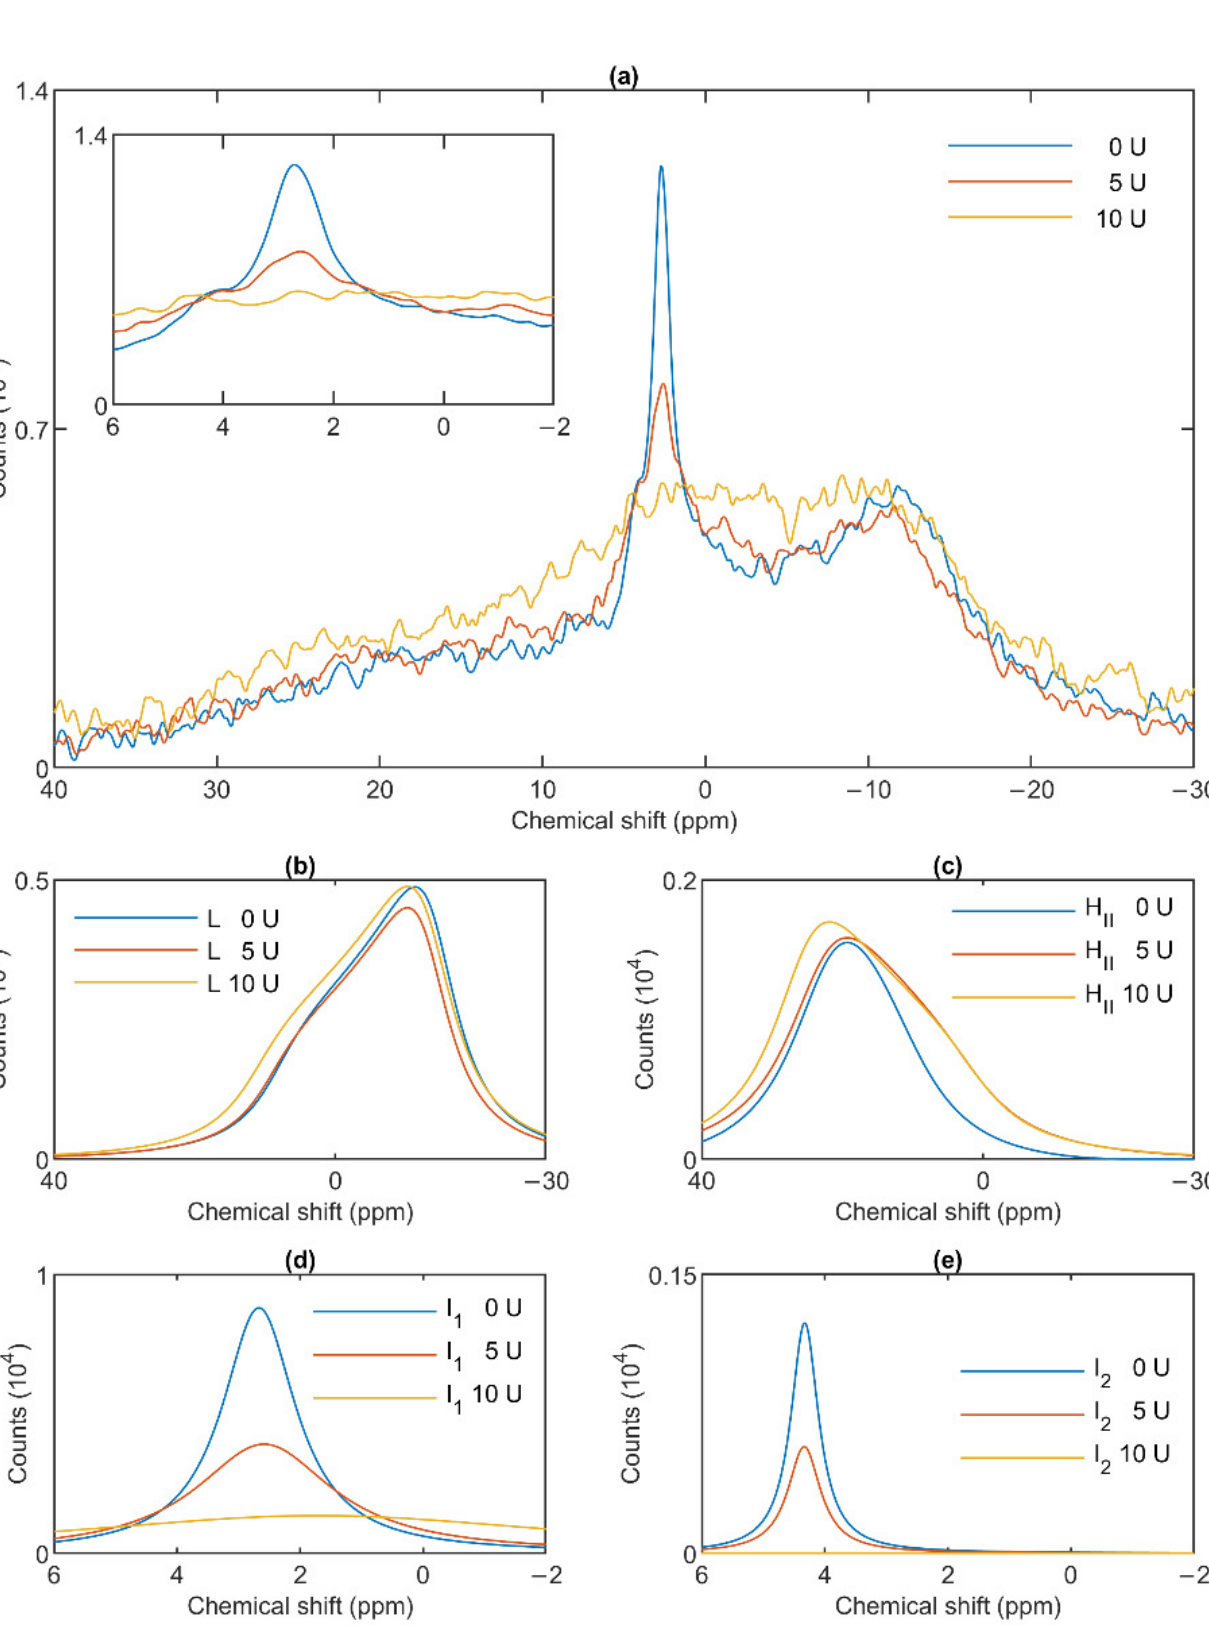
Figure 6. Effects of wheat-germ lipase treatments on the 31 P-NMR spectra ( a ) of granum thylakoid membranes and on their component spectra: L, the lamellar phase ( b ), H II , the inverted hexagonal phase ( c ), and the two isotropic phases, I 1 ( d ) and I 2 ( e ). The spectra represent averages of two measurements from two batches exhibiting similar spectra; recorded at 5 °C. The inset in panel a shows the isotropic region.